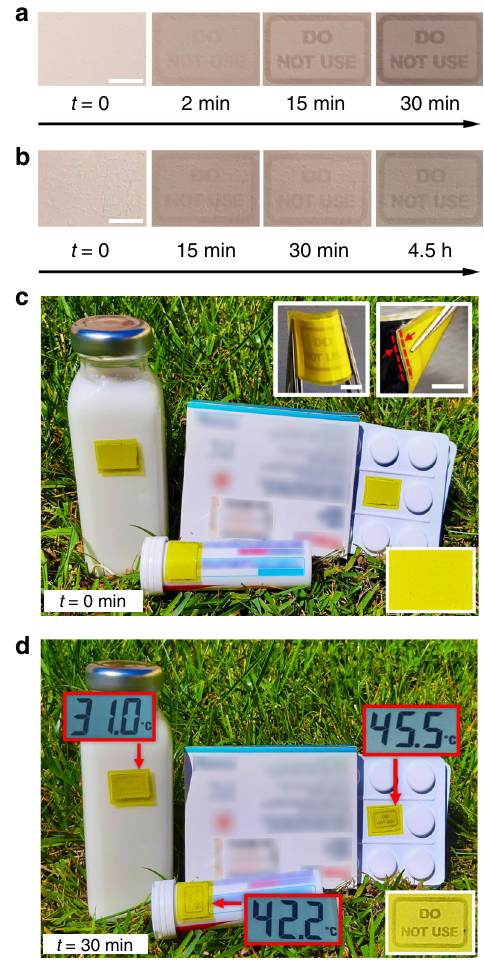
Fig. 4 Flexible time – temperature indicator on paper substrate during operation. a , b Photographs of two differently programmed indicators while working at 35 °C with different response timescales: a minutes (device fi rst photo-programming dose = 72 mJ/cm 2 ) and b hours ( fi rst photo- programming dose = 80 mJ/cm 2 ), captured at different observation times. (Scale bar: 5 mm). c , d Operation during sunlight-induced warming. Exemplary goods (milk, drugs) are exposed to sunlight for 30 min. The temperature of each item, measured by a thermocouple, is displayed in the red box. The photographs also show the corresponding visual response of non-wovens, encapsulated by yellow plastic sheets to screen UV radiation and prevent undesired residual crosslinking ( c , top-right inset, scale bars, 5 mm). In the top-right inset in ( c ), arrows highlight the fl exible and robust multilayer interface at the device edge. Bottom-right insets: magni fi ed view of the indicator on the drug blister, before ( c ) and after ( d ) sunlight